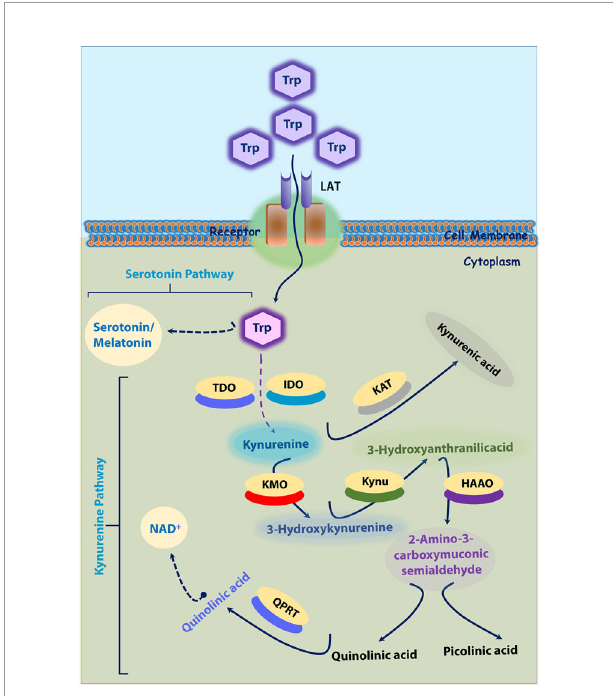
FIGURE 1 | Tryptophan-Kynurenine and Serotonin Pathways. ~95% Trp is transported into cytoplasm by LAT. In cytoplasm, tryptophan is initially converted into kynurenine; Kynurenine into 3-Hydroxykynurenine by KMO; 3- Hydroxykynurenine into 3-Hydroxyanthranilicacid and further quinolinic acid or picolinic acid. In another axis, kynurenine is converted into kynurenic acid by KAT. In another hand, tryptophan (~5%) is converted into serotonin by serotonin pathway. 3-HK, 3-hydroxykynurenine; HAAO -3, hydroxyanthranilic acid dioxygenase; IDO, Indoleamine 2, 3-dioxygenase; KAT, kynurenine amino transferase; KAT, kynurenine amino transferase; KMO, kynurenine monooxygenase; Kynu, kynureninase; LAT, L-amino acid transporters; PA, picolinic acid; QA, quinolinic acid; QPRT, Quinolinate phosphoribosyl transferase; TDO, tryptophan-2,3-dioxygenase;